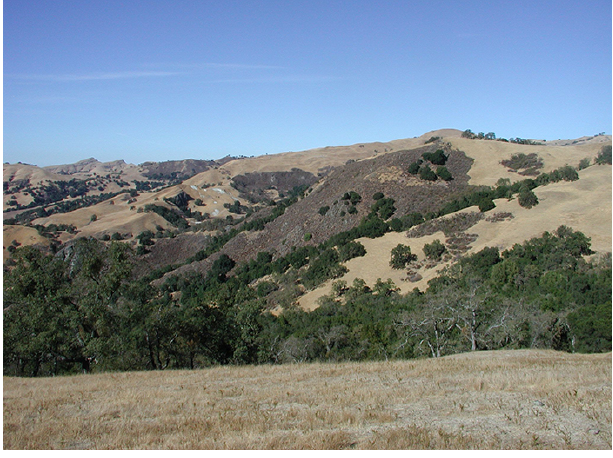
Fig. 2 . Annual grasslands, oak woodlands, and chaparral in the San Francisco Bay